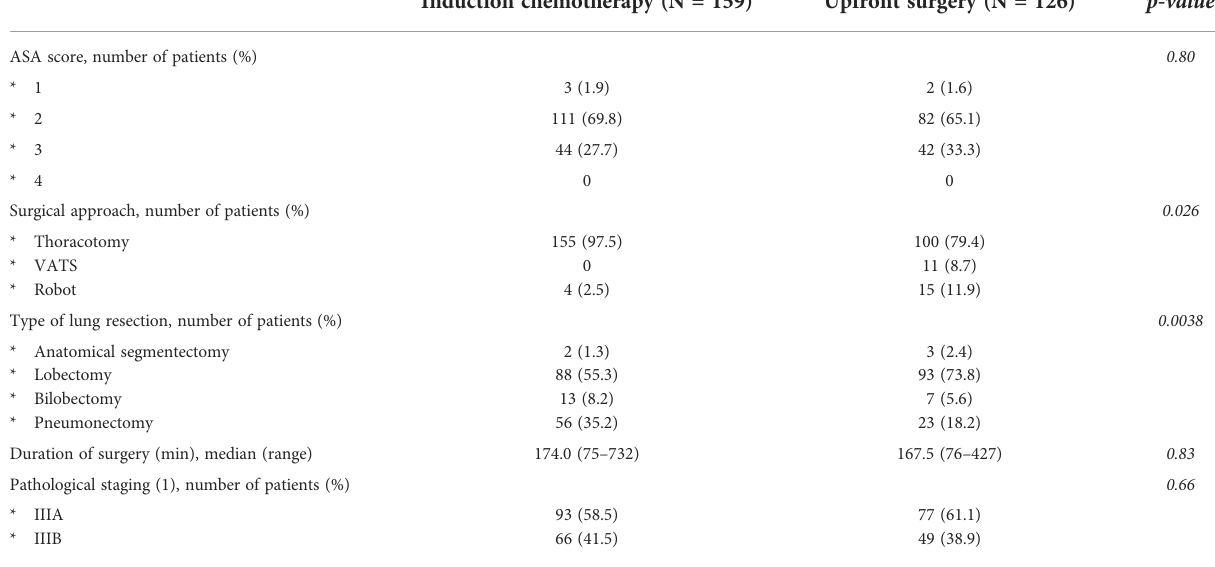
TABLE 2 Preoperative and intraoperative characteristics and pathological analysis of the study population.